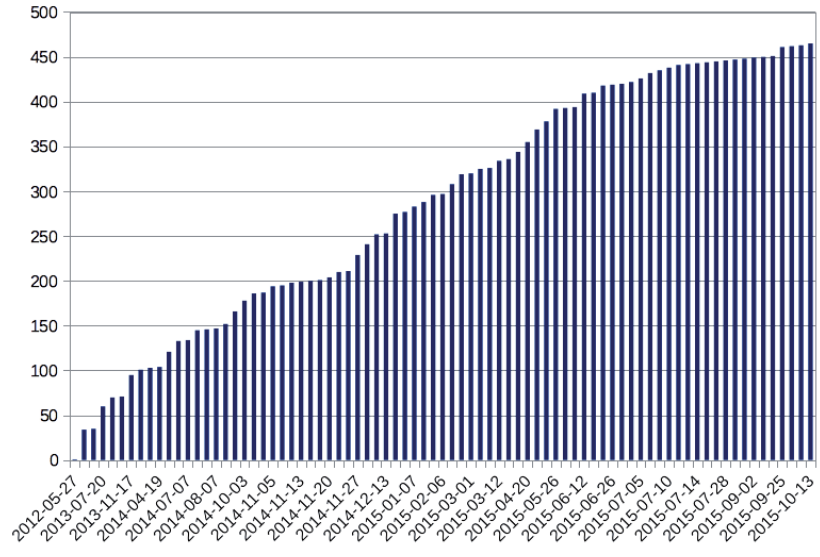
Figure 3. Cumulative number of instructors.